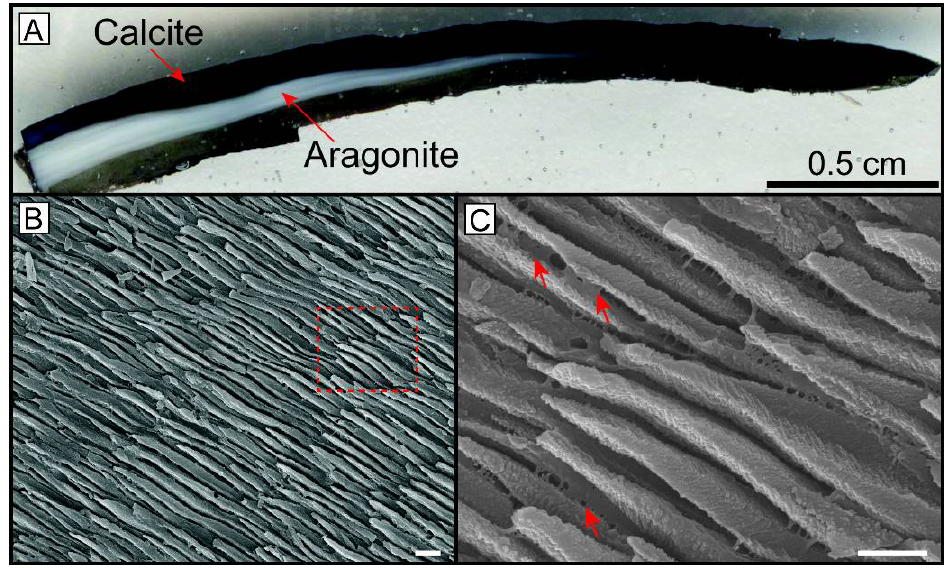
Figure 1. Mytilus edulis shell components. ( A ) Shell section across the thickness, with calcite (blue) in the outer region and aragonite nacre (white) in the inner region; from a similar sample, specimens were extracted from a section nearly perpendicular to the c -axis of both calcite and aragonite; ( B ) SEM image of an etched region of the calcite layer, showing a general view of acicular calcite crystals [dashed red square corresponds to the image shown in ( C ); scale bar = 1 µ m. ( C ) Detail image of ( B ), showing calcite crystals with the inter-crystalline organic matrix (IOM) (red arrows) in between (scale bar = 1 μm).